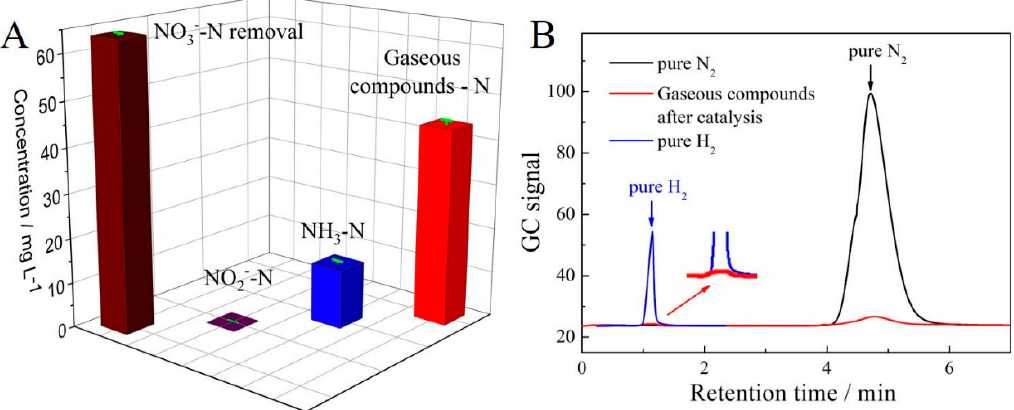
Figure 4. CVs of Pt NFs / CC ( A ) in 0.1 M NaOH containing 20 mM NO 2 − (solid line) and 20 mM Figure 5. ( A ) Concentration of NO 3 − -N removal, NO 2 − -N, NH 3 -N and gaseous compounds-N after NO 3 − (dash line); CVs of Cu / Pt NFs / CC ( B ) in 0.1 M NaOH containing 20 mM NO 3 − . Scan rate is 20 electrocatalysis by Cu / Pt NFs / CC in 0.1 M NaOH containing 20 mM NO 3 − (280 mg L − 1 ); ( B ) mV s − 1 . Chromatogram of the gaseous compounds after electrocatalysis by Cu / Pt NFs / CC.